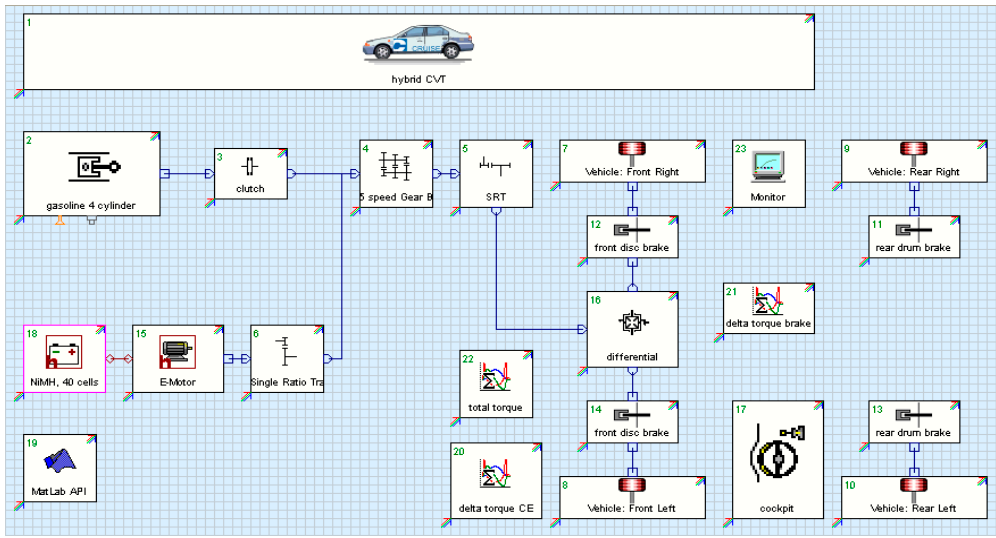
Figure 3. The vehicle model built in AVL Cruise.